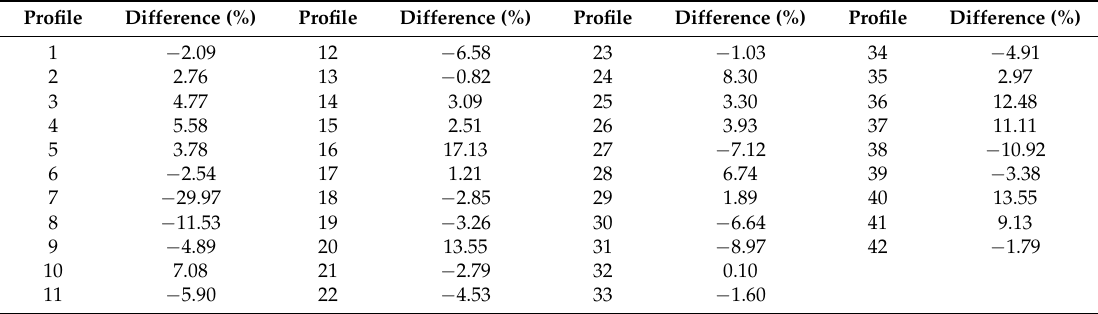
Table 7. DifferencesinNF 3 instantaneous radiative forcing at the top of the atmosphere based upon comparison of the regression model and LBLRTM model